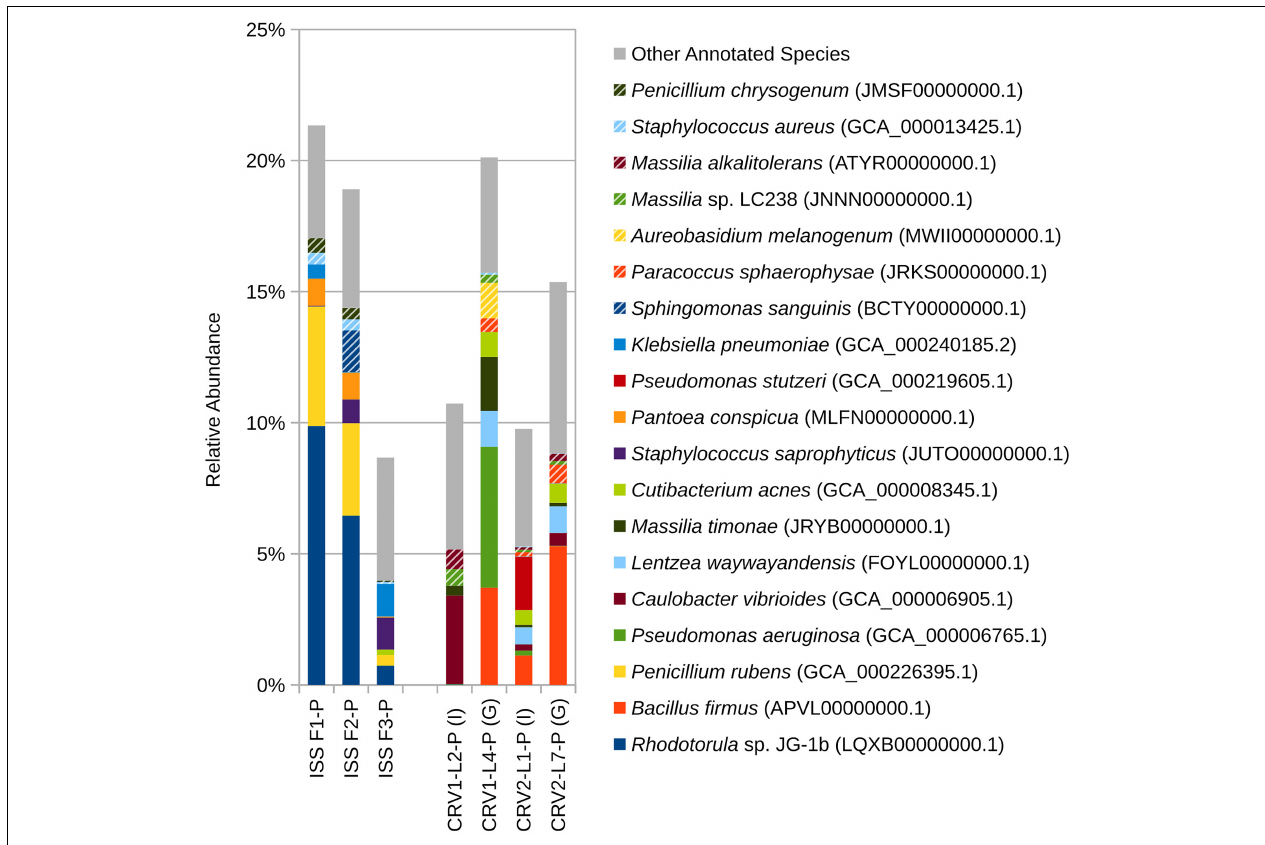
FIGURE 2 | Relative abundance of species based on shotgun metagenomic reads generated from PMA treated samples collected from three sampling events on the ISS and the internal (I) and ground support equipment (G) surfaces of CRV1 and CRV2.